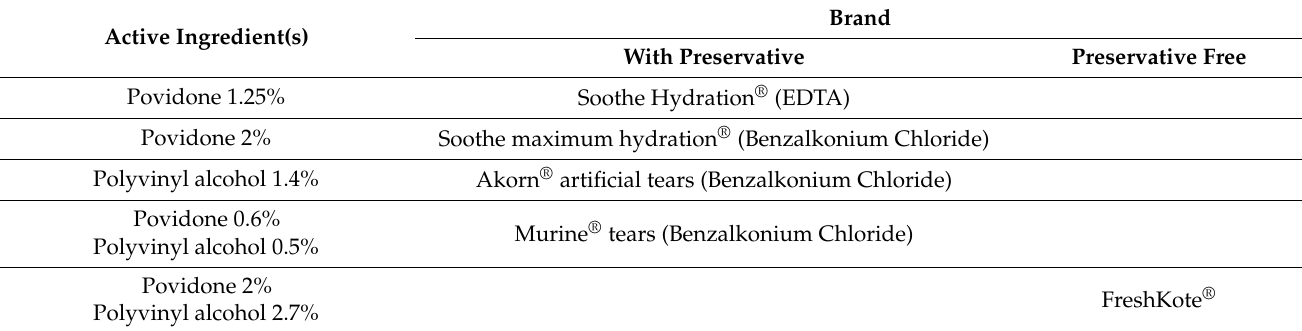
Table 4. Artificial tears containing povidone and polyvinyl alcohol as